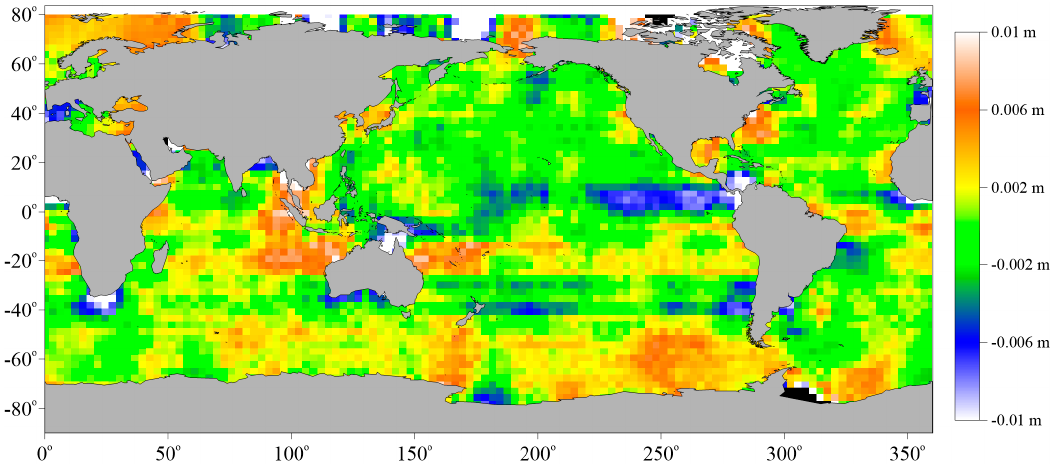
Figure 20. Map of Sentinel-3A SRAL SAR mode SLA differences at the self-crossovers.